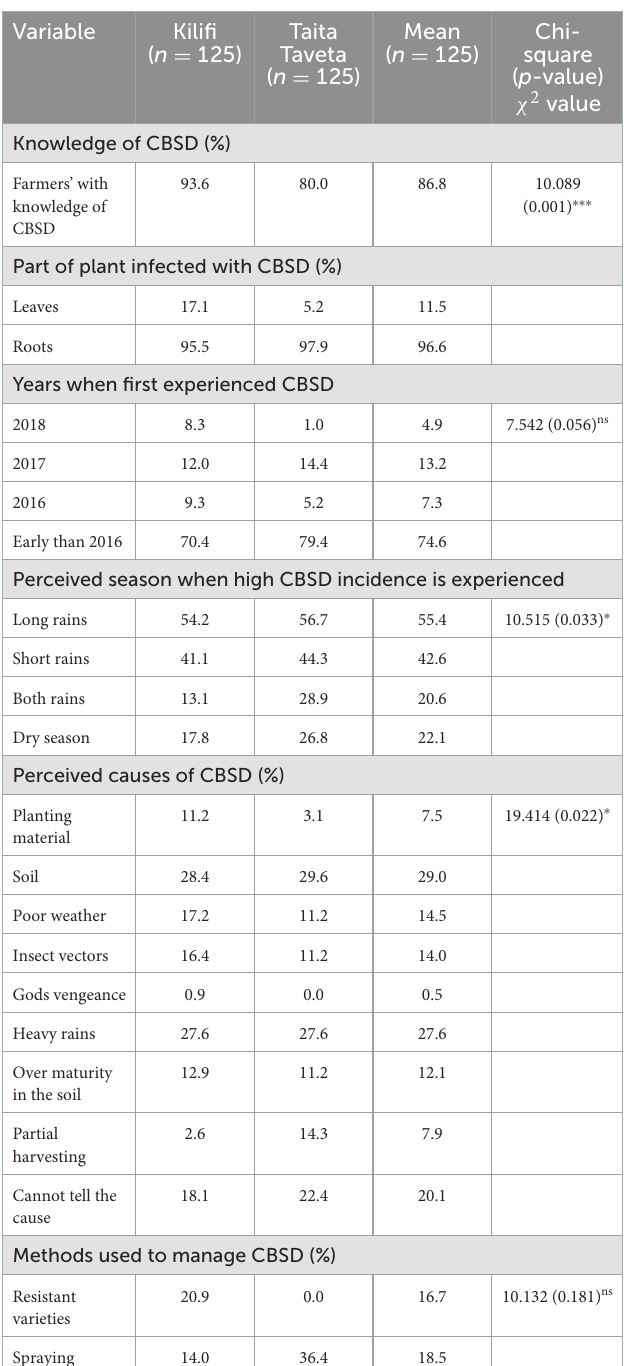
TABLE 4 Farmers’ knowledge of CBSD, perceptions of spread, season of appearance, causes and management practices of CBSD. Variable Kilifi Taita ( n = 125) Taveta